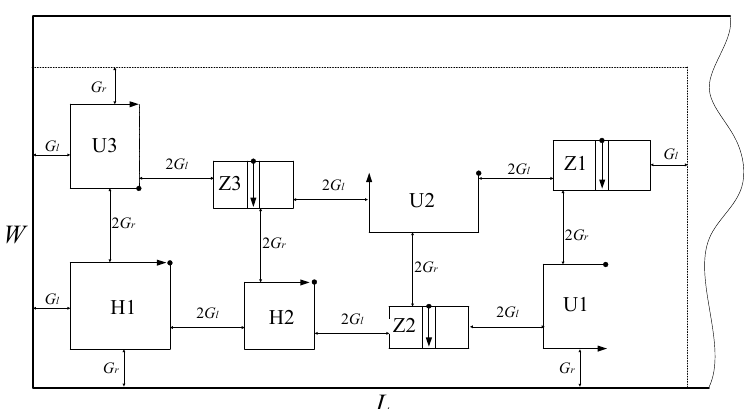
Figure 11. Schematic diagram of the integrated layout between the cells.